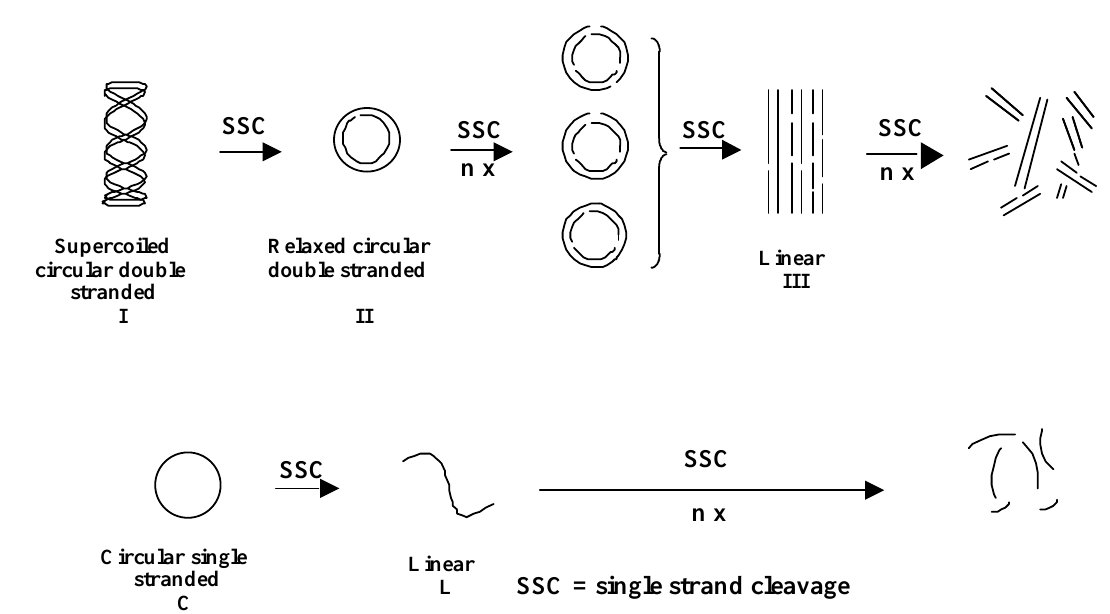
Figure 8. Single-strand cleavage of supercoiled circular double-stranded and of circular single- stranded nucleic